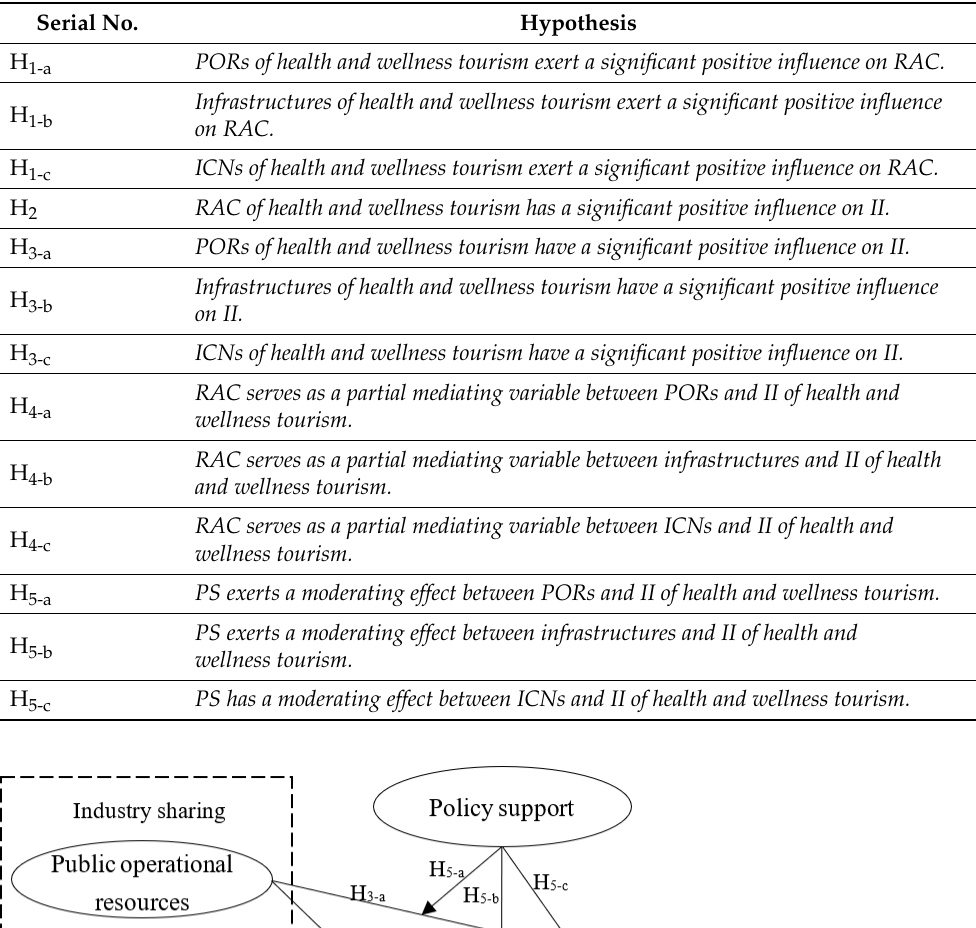
Table 1. Summary of hypotheses.